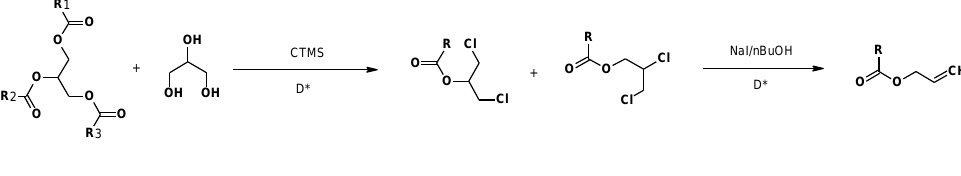
Figure 6. Synthesis of allyl fatty esters, using various fatty materials. Step 1: Conventional heating at 115 ◦ C / 48 h and microwave (MW) were 225 ◦ C, 300 W, 17 atm for 3h. Step 2: Conventional heating was 115 ◦ C / 48 h, and MW was 150 ◦ C for 25